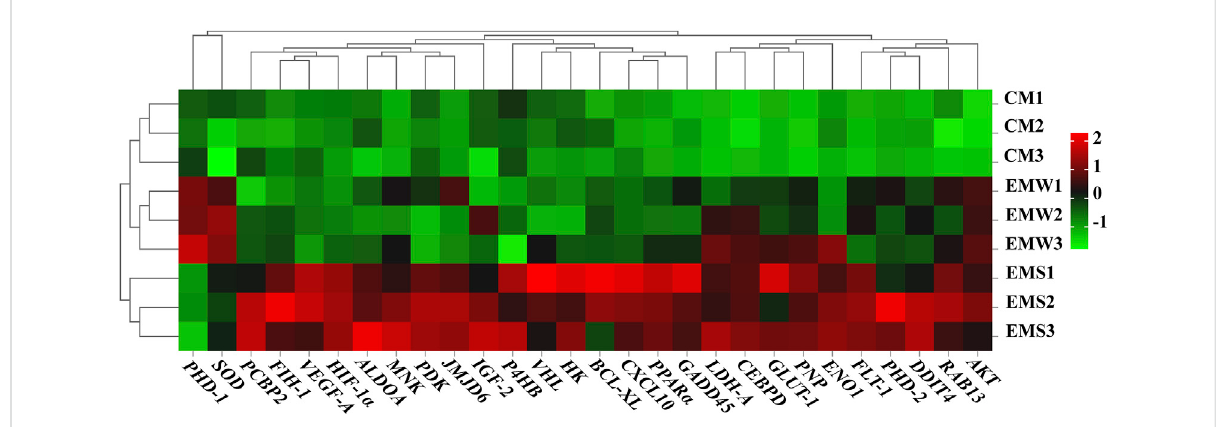
FIGURE 5 Heat map of DEGs in the control and experimental groups. Red represents gene up-regulation, green represents gene down-regulation. CM indicates the normoxic control group of muscle tissue; EMS represents hypoxia-tolerant group of muscle tissue; EMW represents hypoxia-sensitive group of muscle tissue.